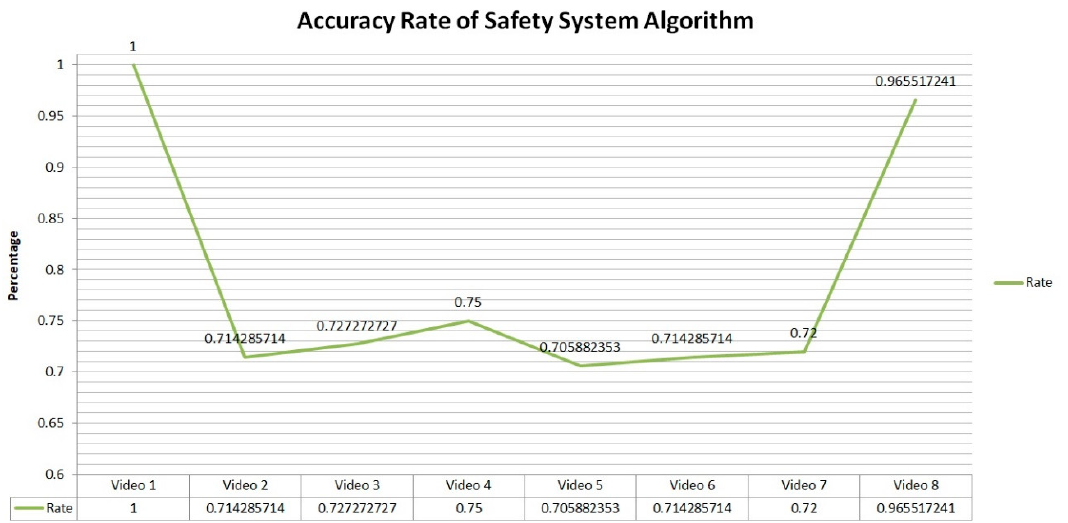
Figure 8. Accuracy rate of the algorithm.